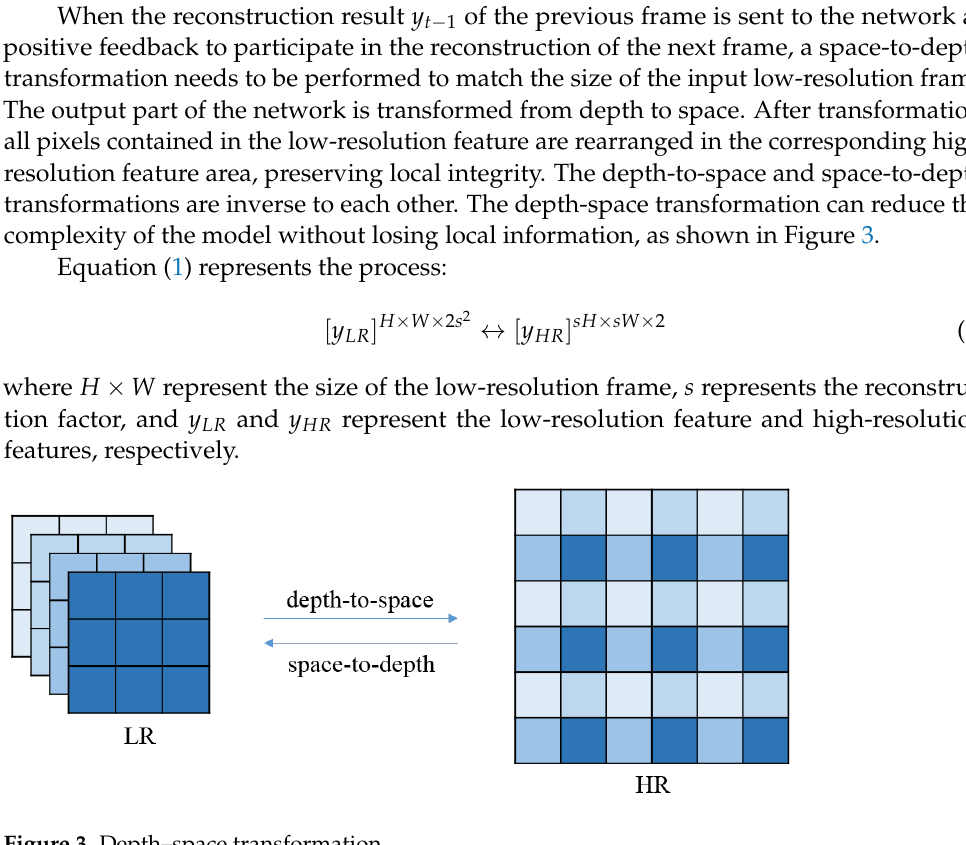
Figure 3. Depth–space